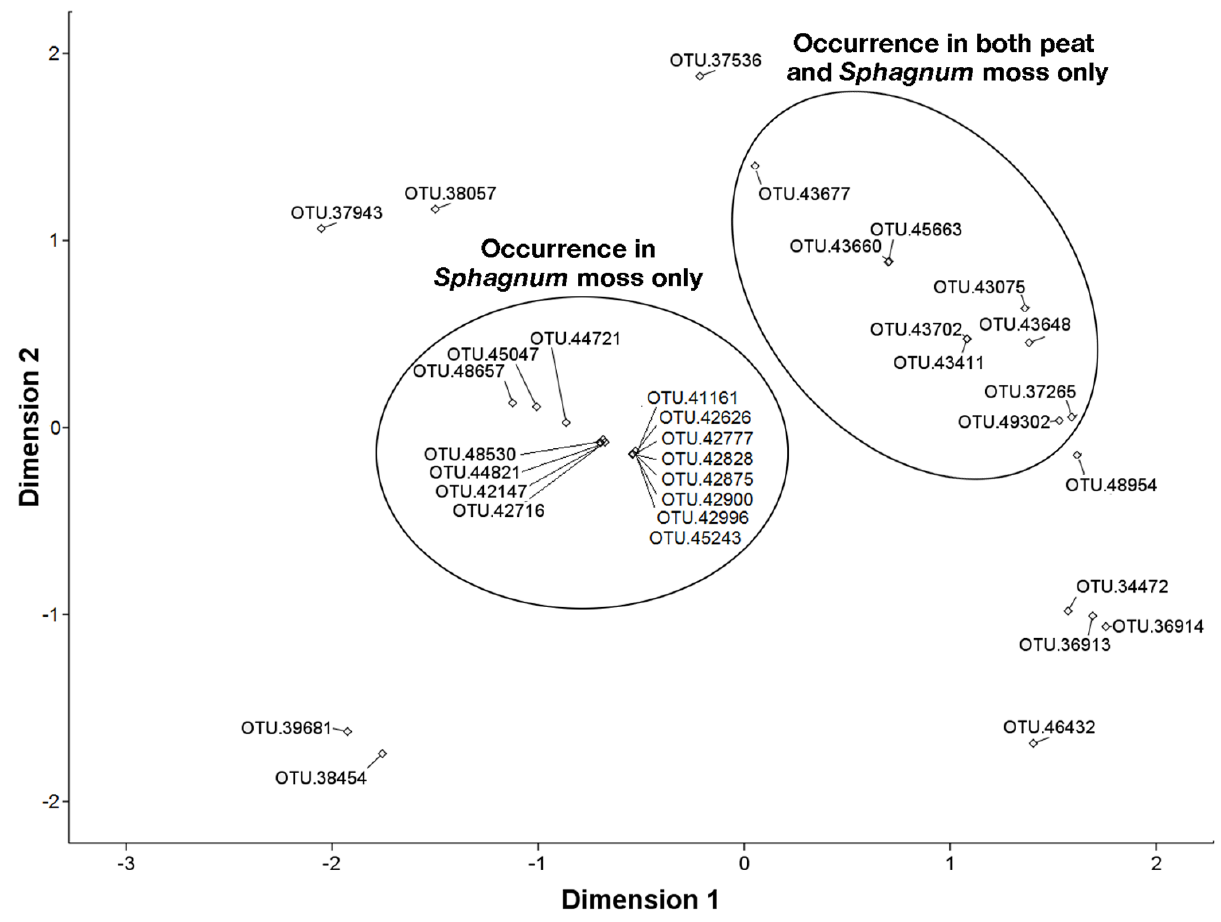
Figure 7. Similarity in the presence and abundance of the Methylocystaceae detected in peat, forest soil, and Sphagnum moss as a two-dimensional plot of nonmetric multidimensional scaling (NMDS; Stress = 0.18333, R 2 = 0.87487). OTUs on the NMDS plot that are closer to one another are more similar in their occurrence. The OTUs from the Methylocystaceae occurring in Sphagnum moss only and in peat and Sphagnum moss only appear to be more similar to one